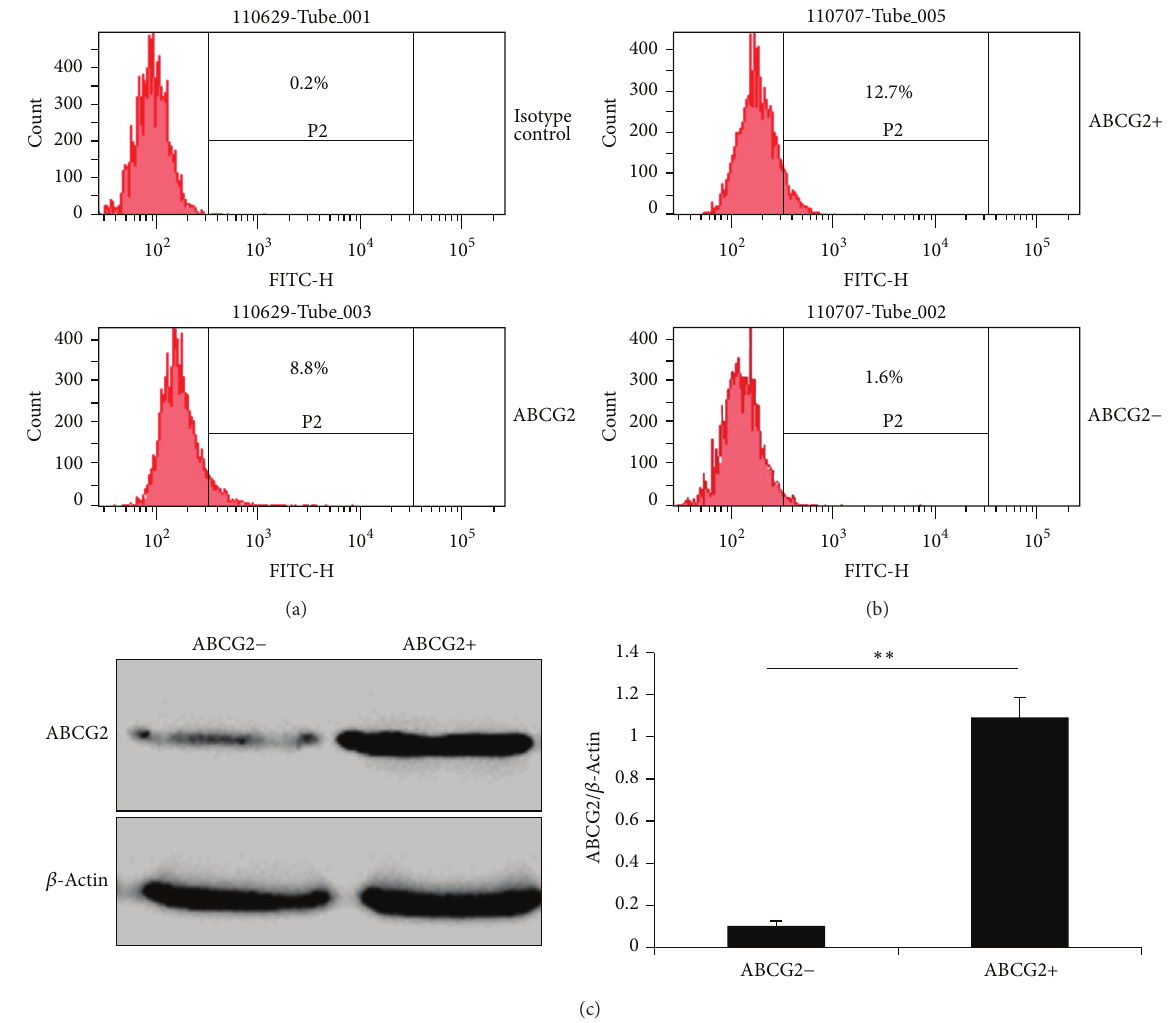
Figure 2: ABCG2 was expressed in a minor population of SMMC-7721 cells. (a) The positive rate of ABCG2 in SMMC-7721 cells determined by flow cytometry was about 8.8% before cell sorting. P2 gate represents ABCG2 positive cells. Mouse IgG2b was used as isotype control. (b) Positive rate of ABCG2 in sorted ABCG2+/ABCG2 − cells after 3 passages of culture. (c) Detection of ABCG2 protein level in freshly sorted cells by western blot. 𝛽 -Actin was used as loading control. The optical density of specific bands was quantified and normalized to 𝛽 -Actin. ∗∗ 𝑃 < 0.01